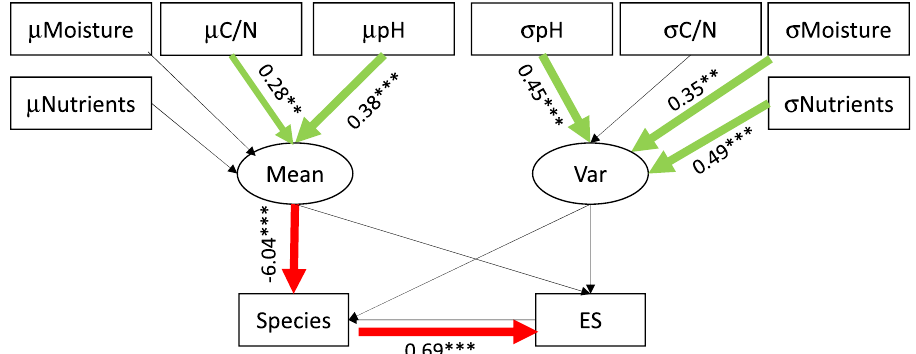
Figure 5. Structural equation modelling including average soil parameters and respective standard deviations (mean ( μ ) and standard deviation ( σ ) of nutrient and moisture demands, pH, and C/N ratio) point to a species richness pathway triggering the degree of species spatial segregation (estimated by the effect size ES of the equiprobable null model). Parametric statistical support: ** P < 0.01; *** P < 0.001. Thickness of arrows is approximately proportional to statistical support of positive (green) and negative (red) influences. Whole model χ 2 > 100, P (df = 44) <